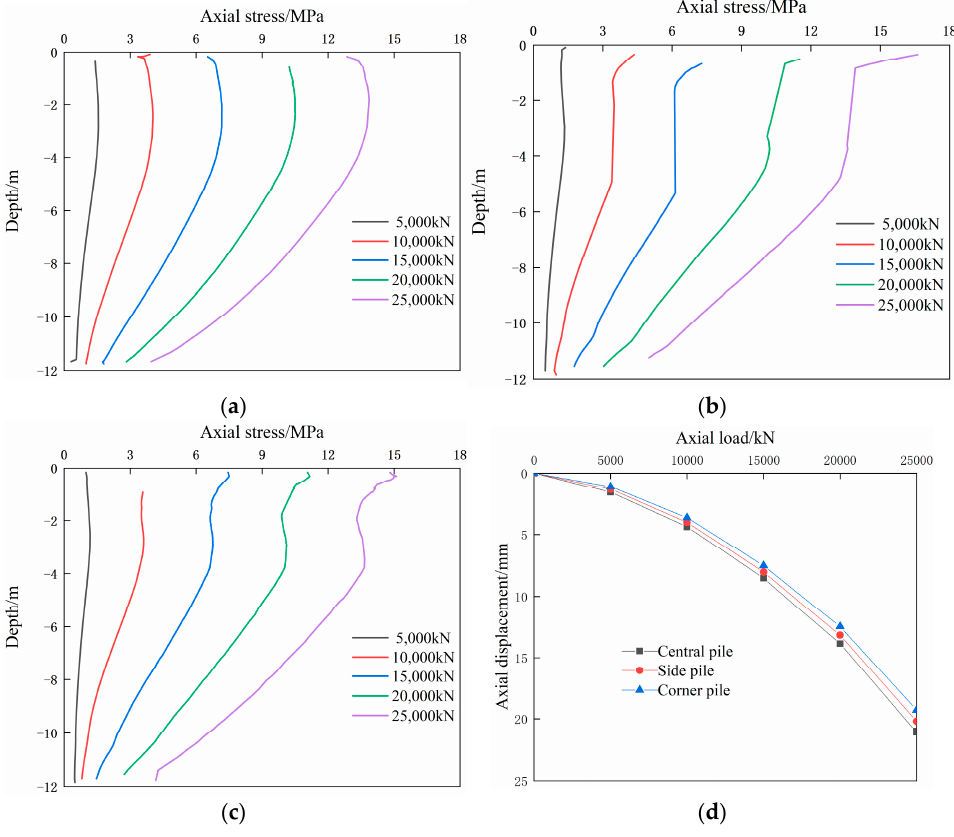
Figure 13. Axial stress and vertical displacement of each pile. ( a ) Axial stress of central pile; ( b ) axial stress of side pile; ( c ) axial stress of corner pile; ( d ) q–s curve of each pile.